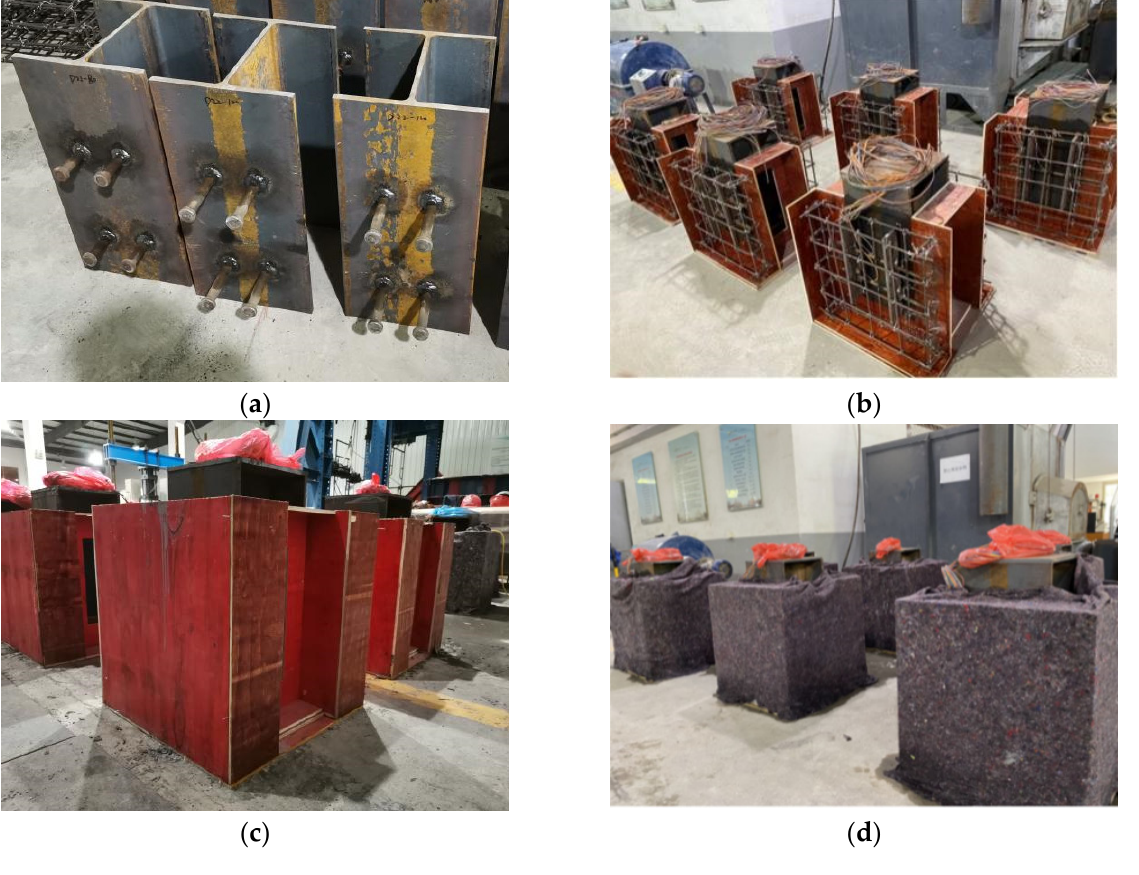
Figure 2. Specimen fabrication process: ( a ) stud welding; ( b ) mold assembly; ( c ) concrete pouring; ( d ) specimen maintenance.